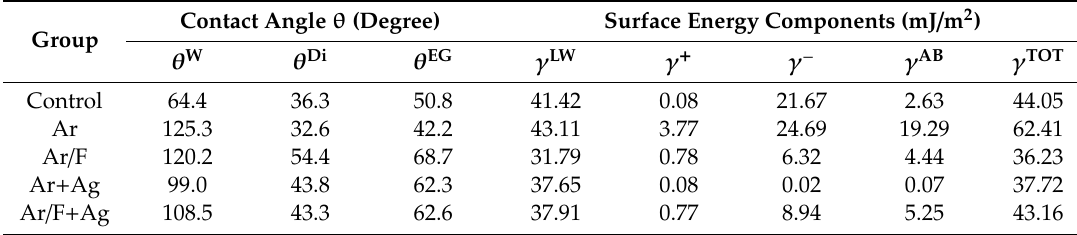
Table 3. Contact angles and Surface free energy